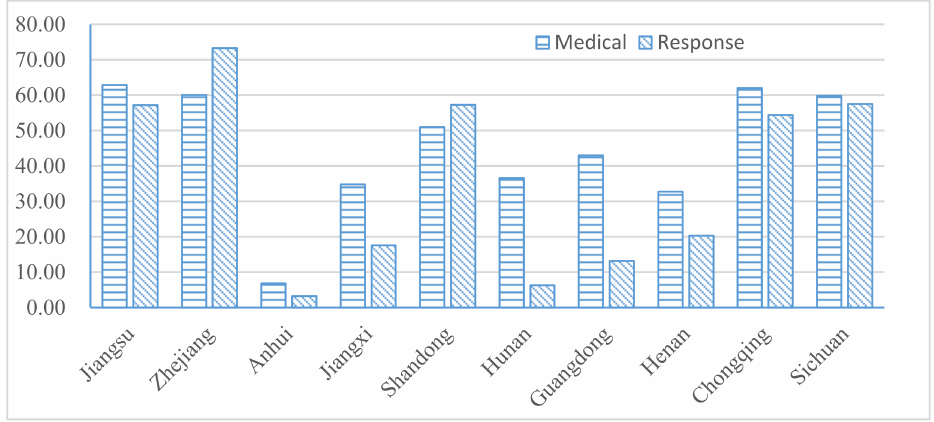
Figure 4. Scores of theoretical medical endurance and response capacity in each